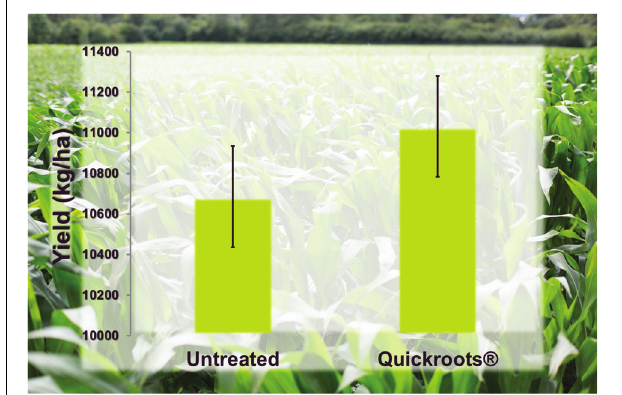
FIGURE 2 | Performance of QuickRoots R (cid:13) ( Bacillus amyloliquefaciens plus Trichoderma virens ) product compared with untreated corn seeds in small plot trials ( N = 104). Error bars represent Standard Error. Yield values are significantly different (two-tailed t -test < 0.001).